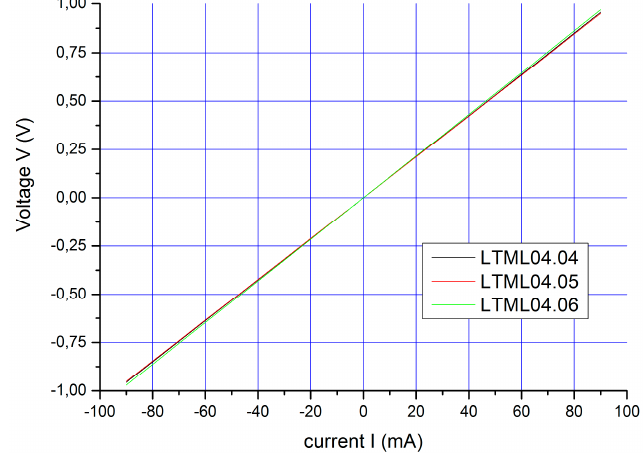
Figure 3. I–V curve measured at a linear transmission line model (LTLM)-structure on a SiC-wafer (200 nm WSi 1.8 on 6H–SiC), annealed for 1 min at 1100 °C.